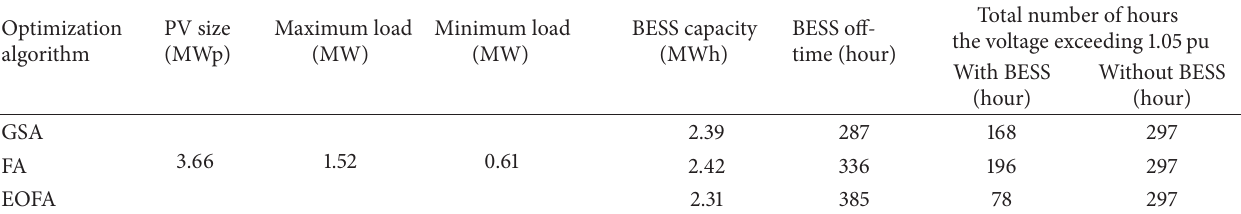
Table 3: Comparison of performance for GSA, FA, and EOFA in battery